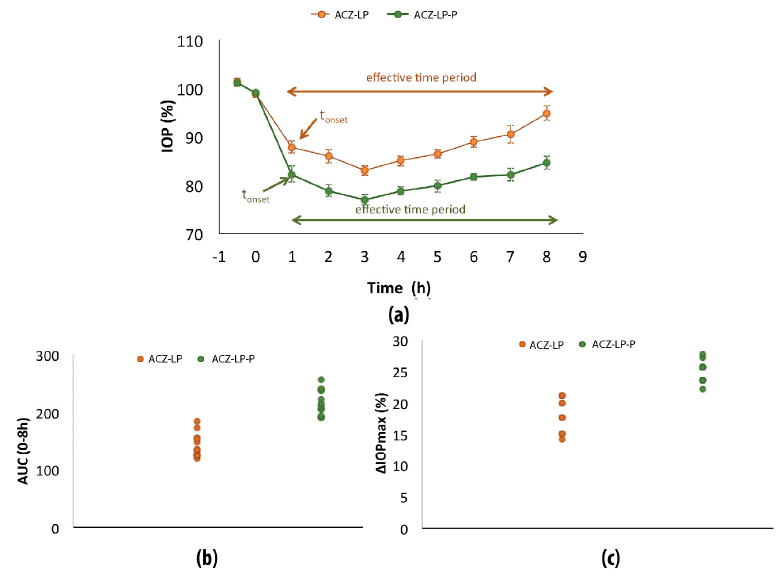
Table 4. Stage one: mean values of area under the Δ IOP-time curve and the Δ IOP max of each treatment (90% confidence limits).